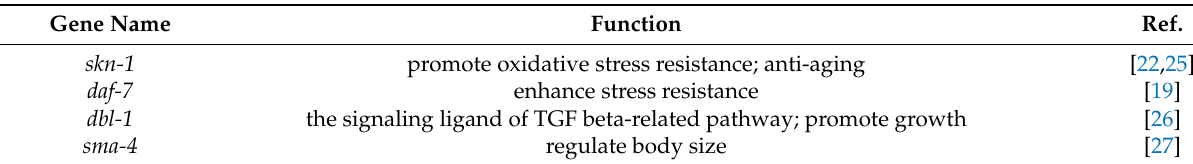
Table 5. The effect of relative genes on C. elegans .